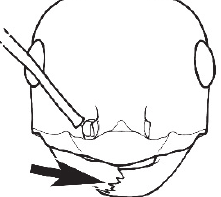
Minor worker (major worker unknown) very similar to M . fieldi complex minor workers in appearance, but with six mandibular teeth and short maxillary palps (as described in couplet 33); basal tooth the same size as the other non- apical teeth and not offset, masticatory margin of mandible almost vertical; in full-face view, anterior clypeal margin evenly convex; in profile, clypeus protuberant (as in many fieldi complex minor workers); clypeal psammophore set at midpoint of clypeal sclerite (NSW) (Fig. 81a–d) ...................... hexidens